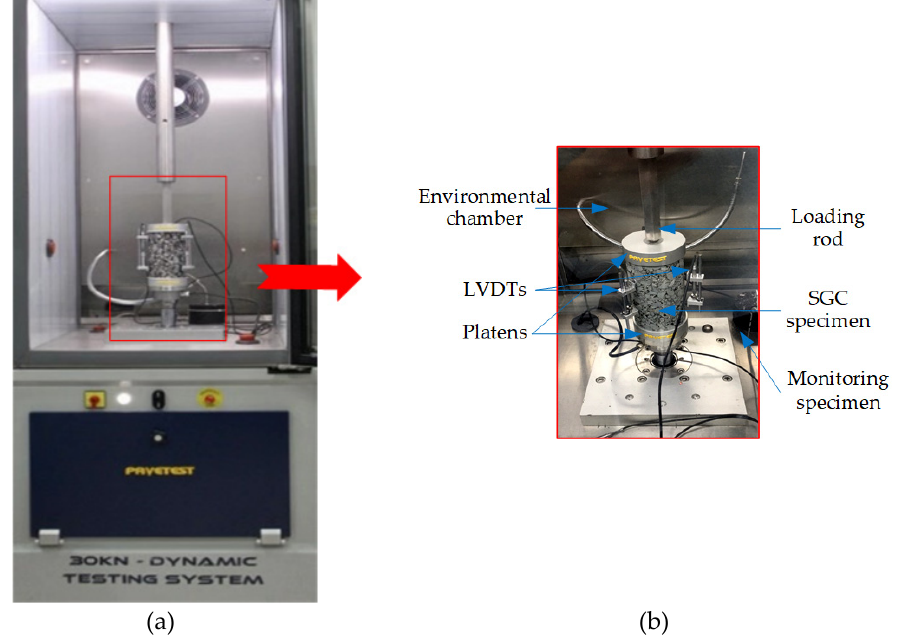
Figure 4. Complex modulus test used in this paper: ( a ) Dynamic testing system (DTS), ( b ) complex modulus test.